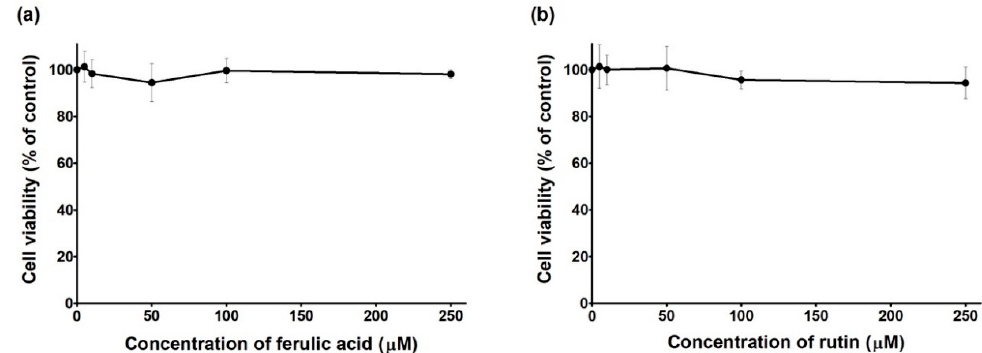
Figure 3. Cell viability of MDA-MB-231 cells exposed to ferulic acid ( a ) and rutin ( b ) for 48 h. The cell viability was evaluated by the CV assay. Values represent mean ± SD (n = 4–5) and are expressed as percentages of the non-treated control cells.